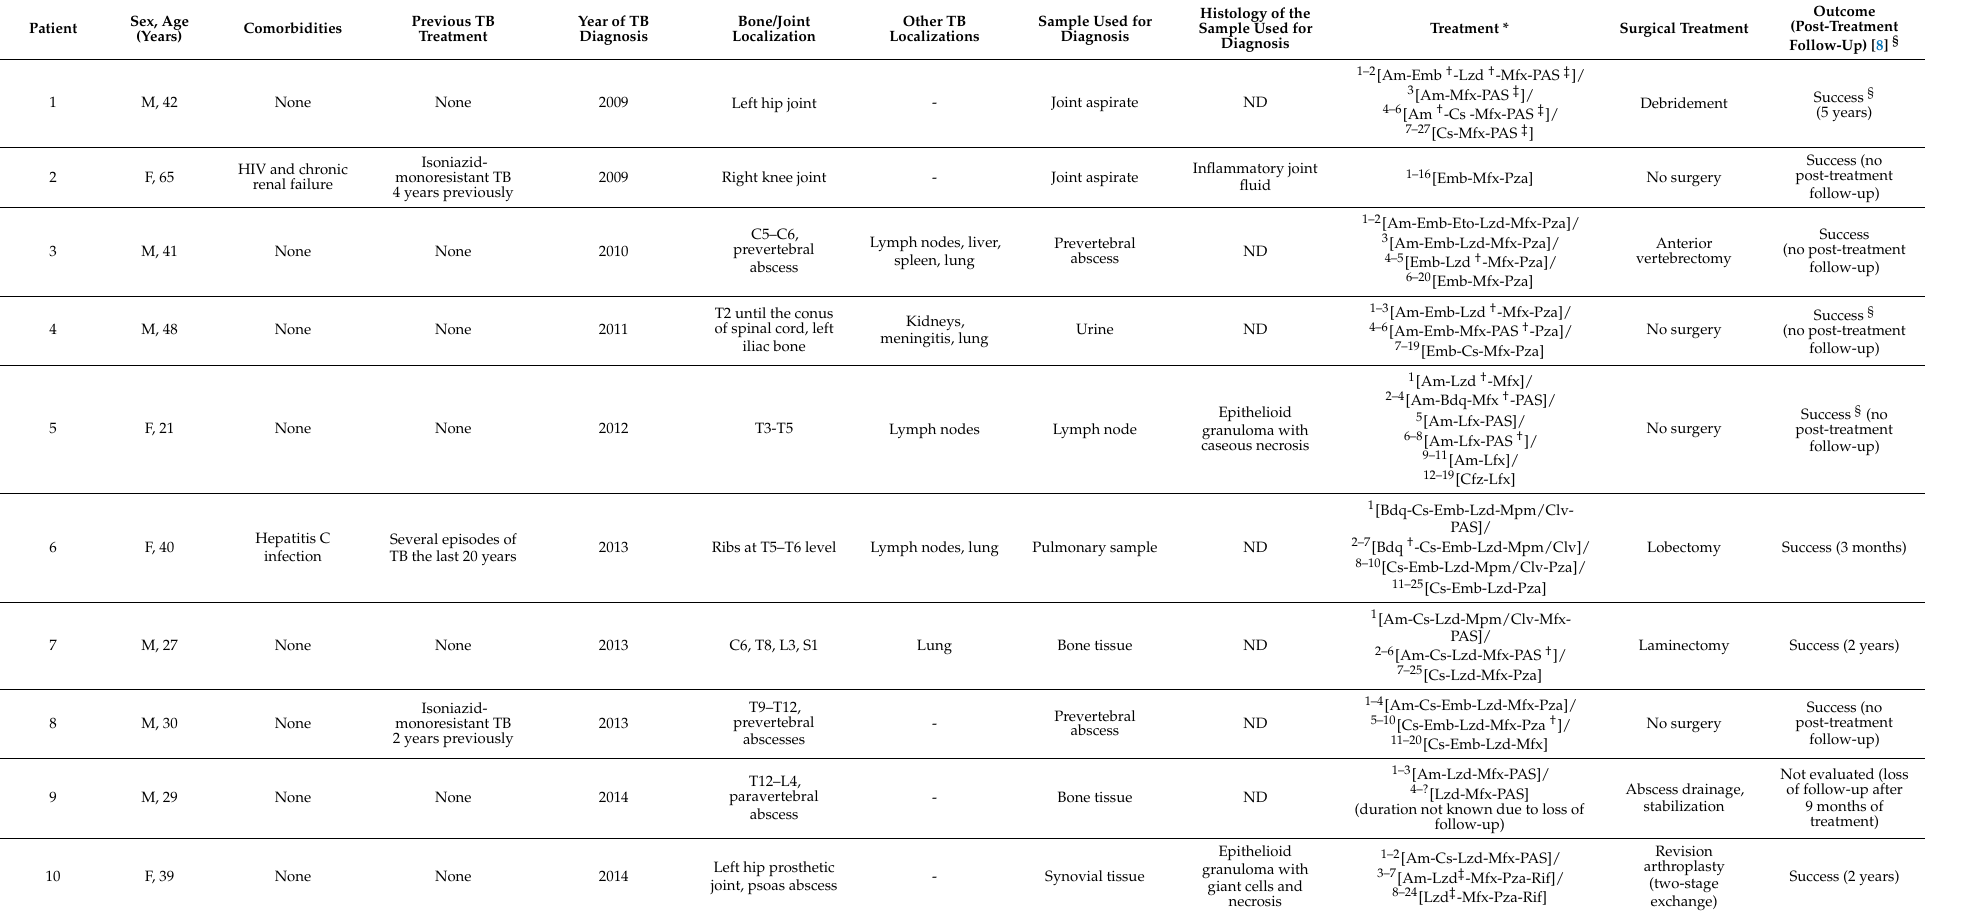
Table 2. Clinical features of multidrug-resistant osteoarticular tuberculosis in France from 2007 to